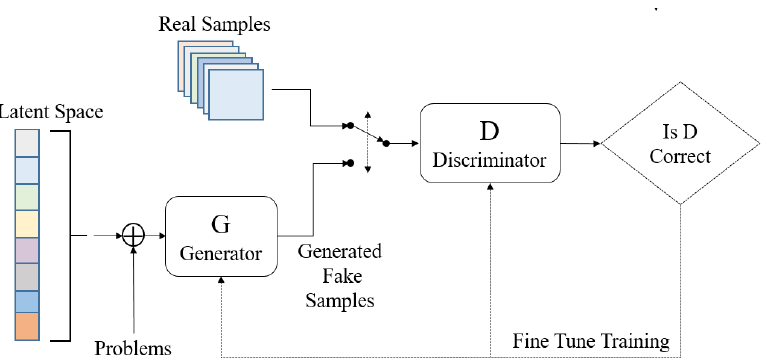
Figure 1. Flow chart of GAN. Table 1. Parameters in the mechanical model.